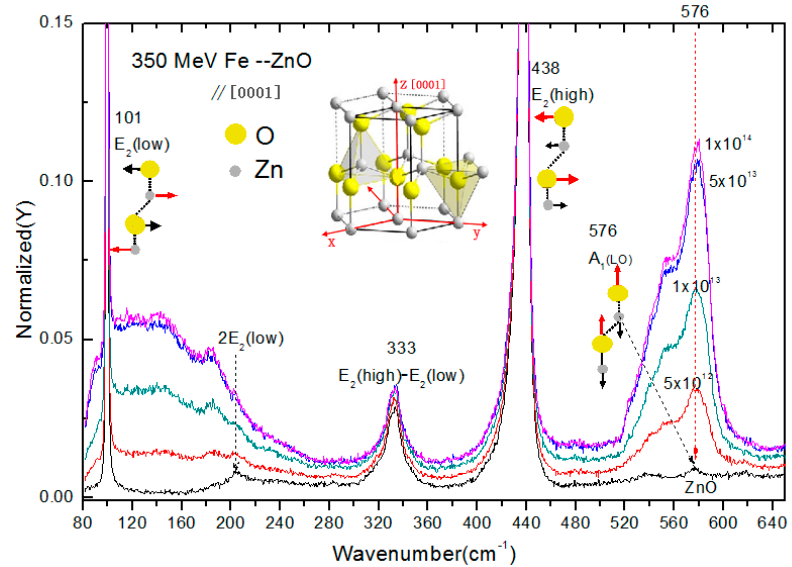
Figure 1. Raman spectra of ZnO irradiated and unirradiated by 56 Fe 21+ ions were measured. Direction of the laser was along the axis [0001] of the crystal. The ZnO structure of wurtzite is shown in the figure. The Raman peaks are assigned by corresponding atomic oscillations (the motion of the dominant atom is indicated by the red arrow).